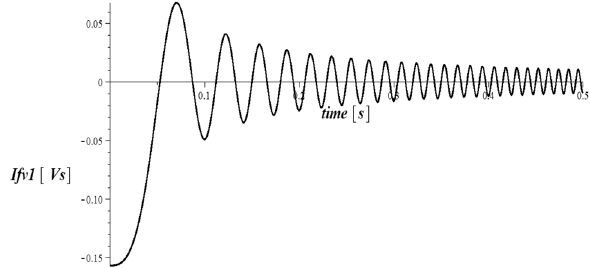
Fig. 3 Solution of the voltage integral (7), in case of linear increase of frequency, from f 0 = 0 (Hz) to f k = 50 (hz) , T = 0.6 (s) by the use of Fresnel